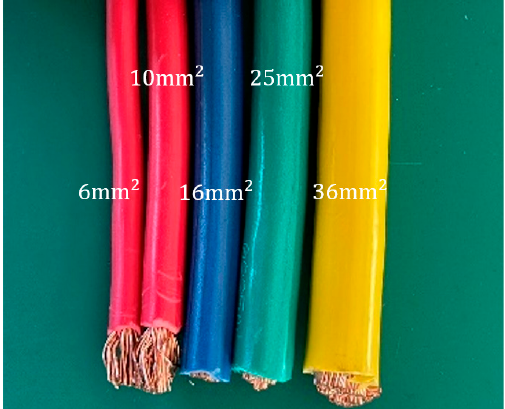
Figure 17. Different types of wires to be tested.